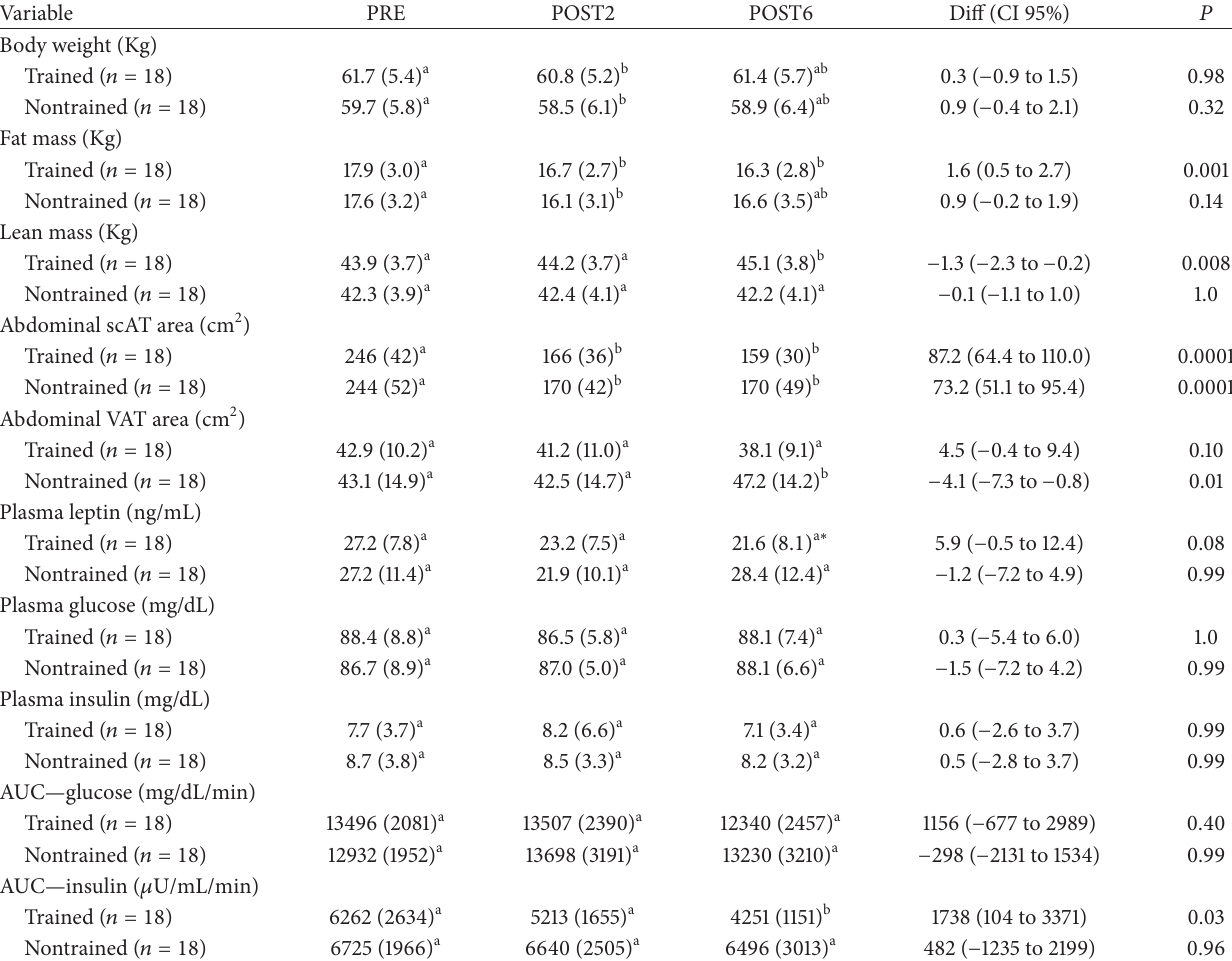
Table 2: Effects of liposuction combined with exercise training on body composition and blood parameters in adult